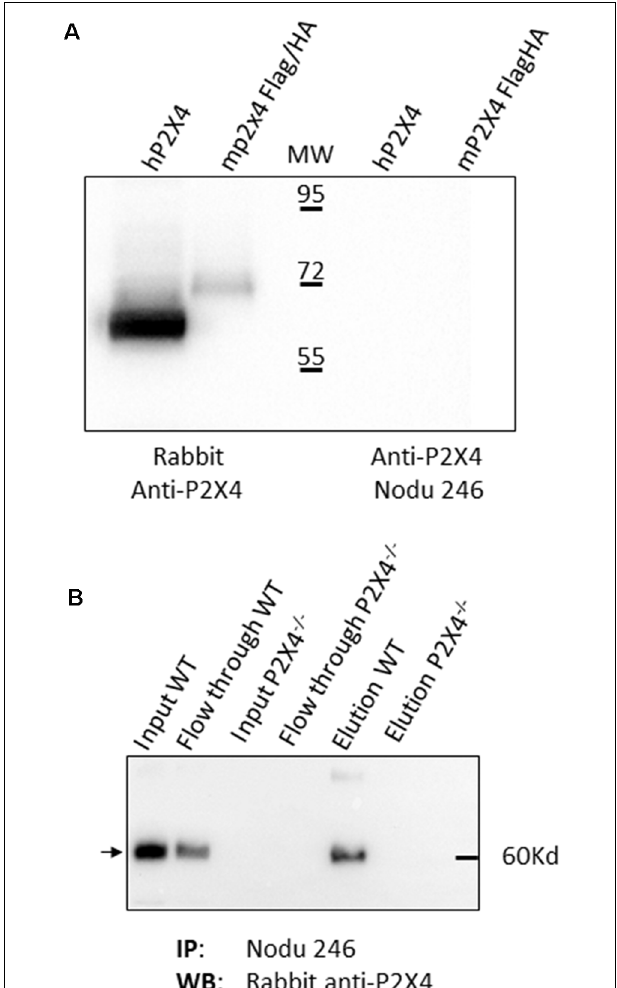
FIGURE 2 | Biochemical properties of Nodu 246 hybridoma. (A) Recognition of denatured human and mouse P2X4 receptors by mAb Nodu 246 was assessed by Western blotting. Protein extracts from a HEK cell line stably expressing the human P2X4 and HEK cells transiently transfected with an expression construct for Flag/HA-tagged mouse P2X4 were analyzed by Western blot after electrophoresis of cell lysates on an SDS-polyacrylamide gel. Blots were incubated either with a rabbit polyclonal anti-P2X4 peptide antibody (Alomone) or with rat monoclonal antibody Nodu 246. Bound antibodies were revealed with peroxidase-conjugated anti-rabbit IgG or anti-rat IgG. The monoclonal mAb Nodu 246 evidently does not recognize the denatured forms of human and mouse P2X4 (right panel), as opposed to the rabbit polyclonal anti-peptide antibody (left panel). (B) P2X4 in mouse WT and P2X4 KO bone marrow-derived macrophage (BMDM) was specifically immunoprecipitated with Nodu 246. Immunoprecipitated proteins were separated by electrophoresis on SDS-polyacrylamide gels and immunoblotted with a polyclonal rabbit anti-P2X4 peptide antibody (Alomone). The same protein extracts were loaded on both panels. Note the higher apparent molecular weight of the Flag/HA-tagged mouse P2X4 compared to human